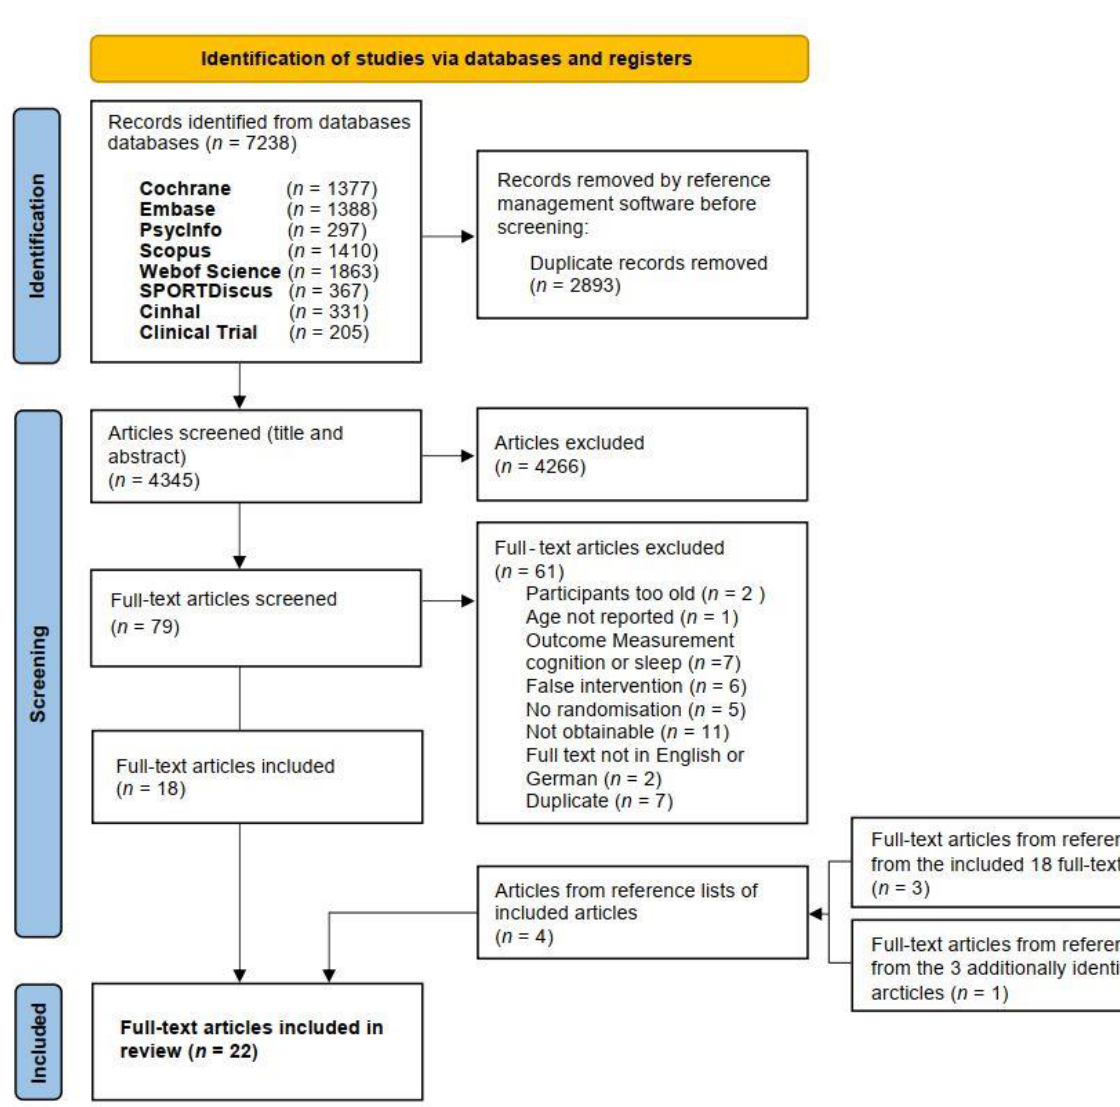
Figure 1. Reference selection process.